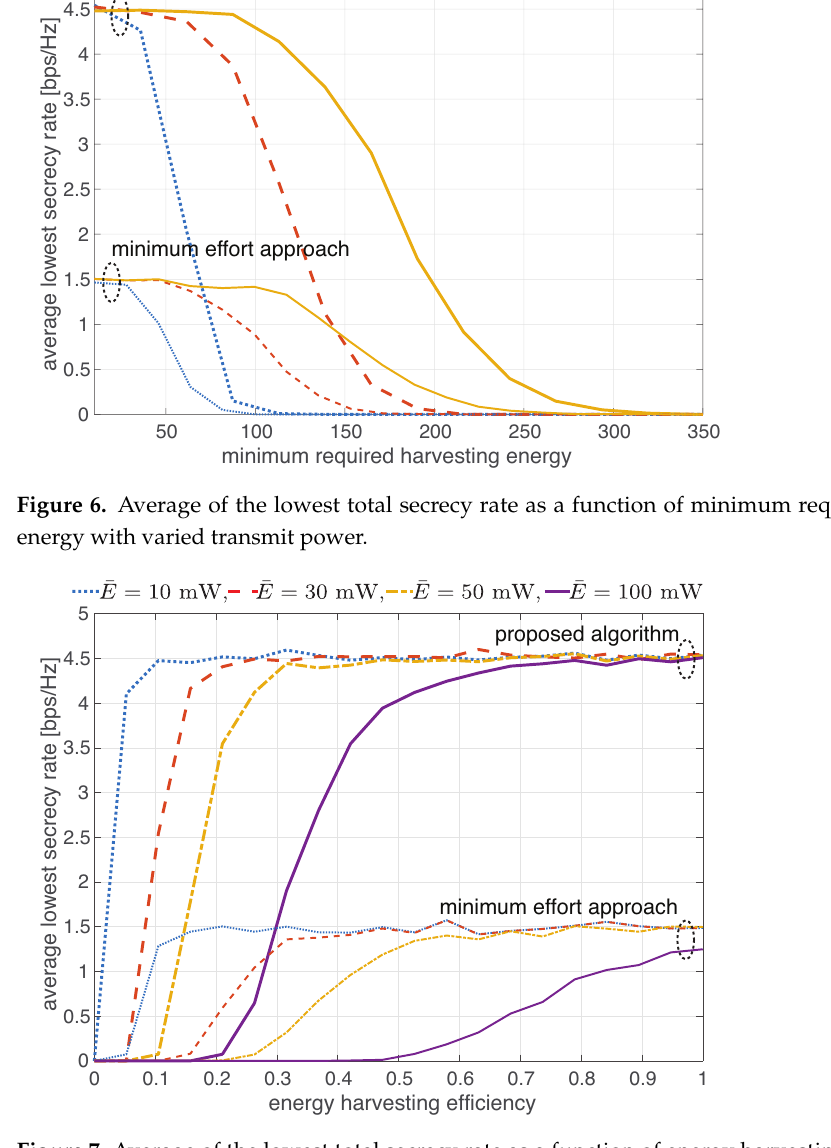
Figure 7. Average of the lowest total secrecy rate as a function of energy harvesting efficiency with varied minimum required harvesting